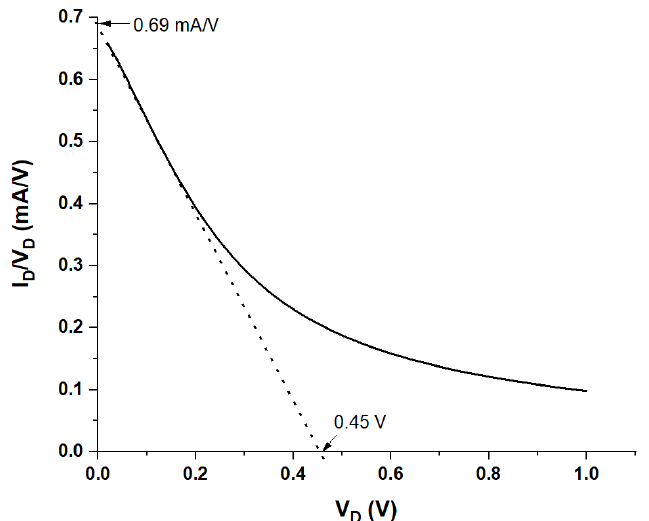
Figure 5. Example of the evaluation of outputs according to Equation (2). c = 0.8 µ g/mL. V DX = 450 mV, (I D /V D ) X = 0.69 mA/V.